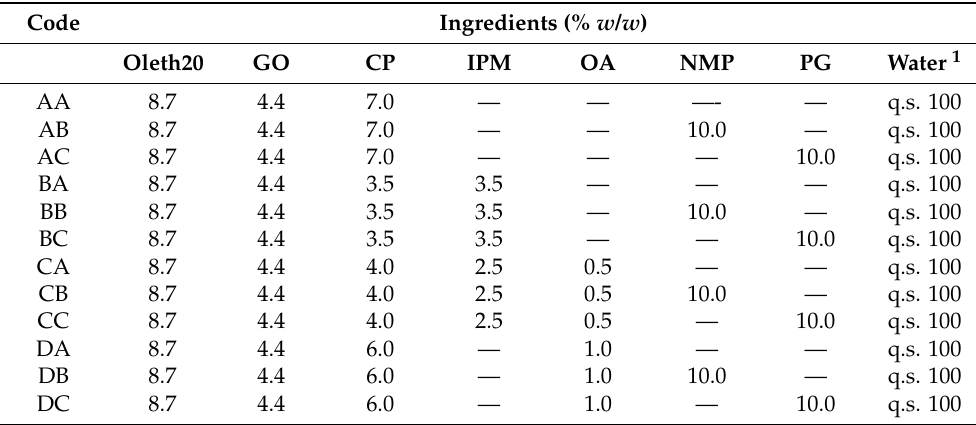
Table 1. Composition (% w / w ) of formulations AA–DC containing idebenone 0.7% w / w . GO = glyc- eryl oleate, CP = cetyl palmitate, IPM = isopropyl myristate, OA = oleic acid, NMP = N - methylipyrrolidone, PG = propylene glycol.